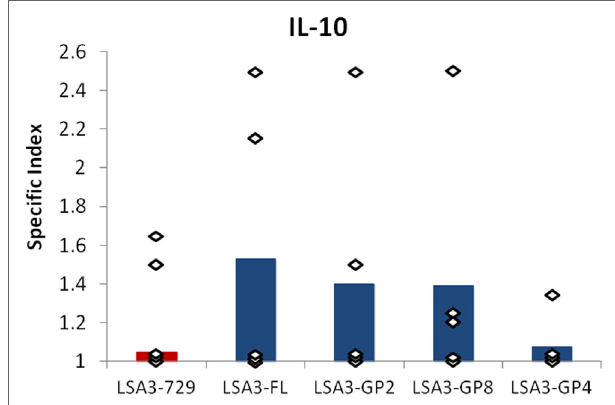
FigUre 5 | IL-10 production induced in spleen cells from liver stage antigen 3-full length (LSA3-FL) immunized mice by peptides LSA3-GP2 and LSA3-GP8. Spleen cells of the LSA3-FL immunized humanized-spleen cells-NOD-SCID-gamma null mice were stimulated in vitro with three synthetic peptides of LSA3 (LSA3-GP2, -GP8, and -GP4). The specific production of IL-10 was measured by enzyme-linked immunospot. The specific index is the ratio of spot forming cells (SFC) of in vitro stimulated cells over SFC of non stimulated cells. Data are presented as mean values of the results obtained with each stimulating antigen using human spleen cells from five different donors. Each dot corresponds to the result obtained with spleen cells pooled from mice of one experimental